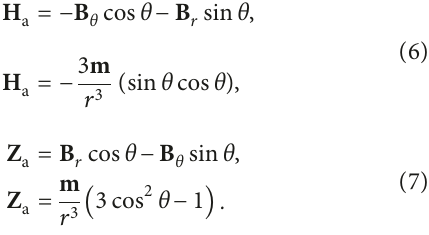
Figure 4: Model formation showing tangential B components of the induced vehicular magnetic anomaly at r distance from the vehicle’s current